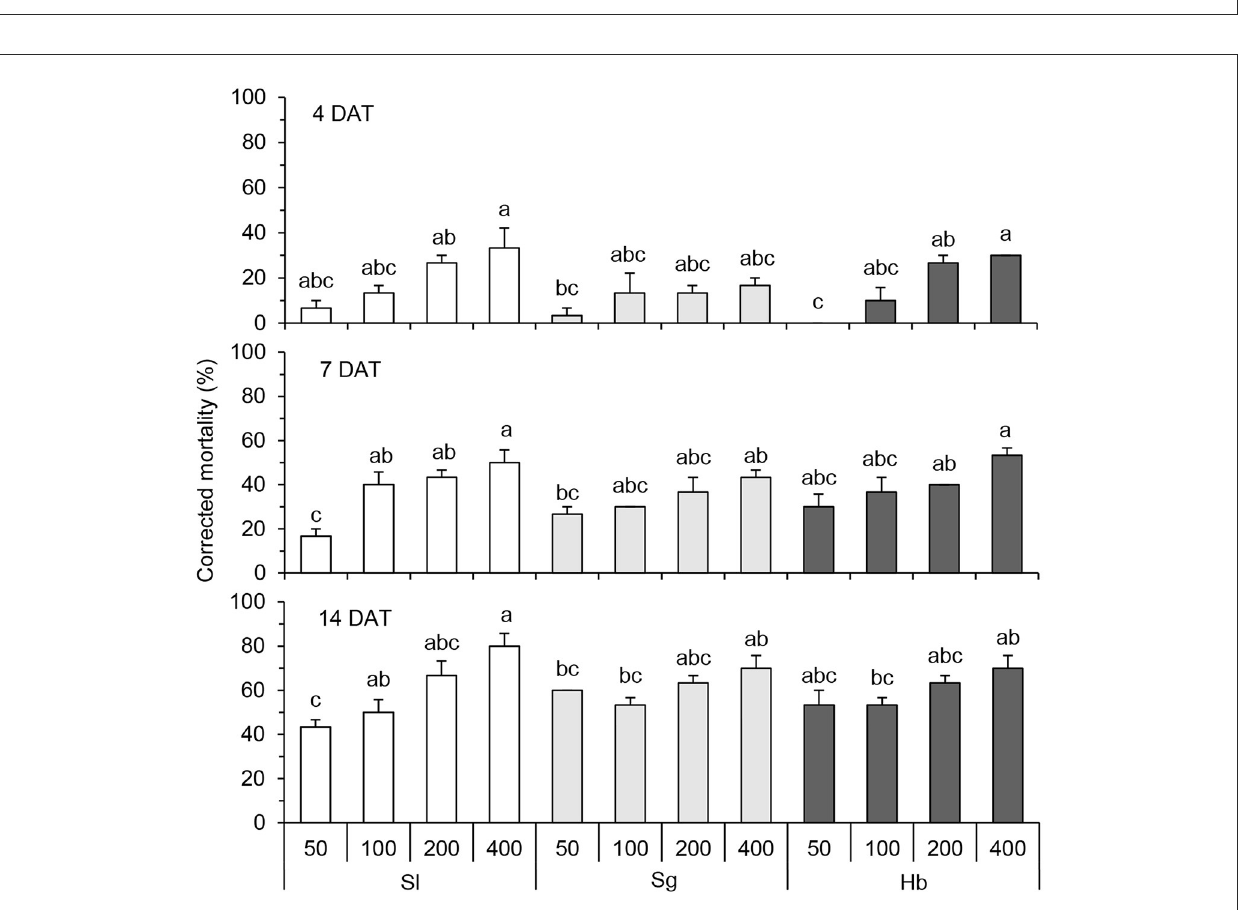
FIGURE2 Corrected mortality of Holotrichia oblita Faldermann treated with Steinernema longicaudum X-7 (Sl), S . glaseri KG (Sg), and Heterorhabditis bacteriophora H06 (Hb) at rates of 50, 100, 200, and 400 IJs per larva evaluated at 4, 7, and 14 DAT. Different letter(s) on the bars represent significant differences among treatments on the same day ( P < 0.05, Tukey’s